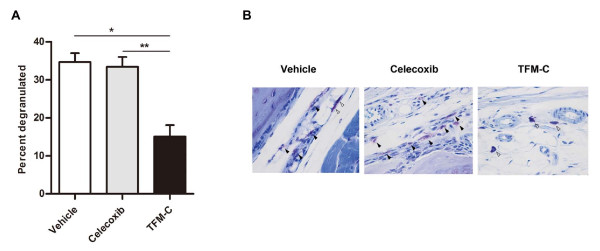
TFM-C inhibits the mast cell activation in CAIA. CAIA was induced in B6 mice and the mice were then treated with 10 μg/g TFM-C, celecoxib or vehicle as described in Figure 2. A. Quantification of degranulated mast cells in synovium of joints 12 days after induction of CAIA. * P < 0.05, compared with vehicle-treated group. * P < 0.05, compared with celecoxib-treated group. Results shown are the mean + SEM of six mice per group and were pooled from two experiments. B. Hisopathologic features of degranulated or intact mast cells in joints of representative vehicle-, celecoxib- and TFM-C- treated mice (toluidine blue stained; original magnification, × 100). White arrows indicate intact mast cells and black arrows indicate degranulated mast cells.